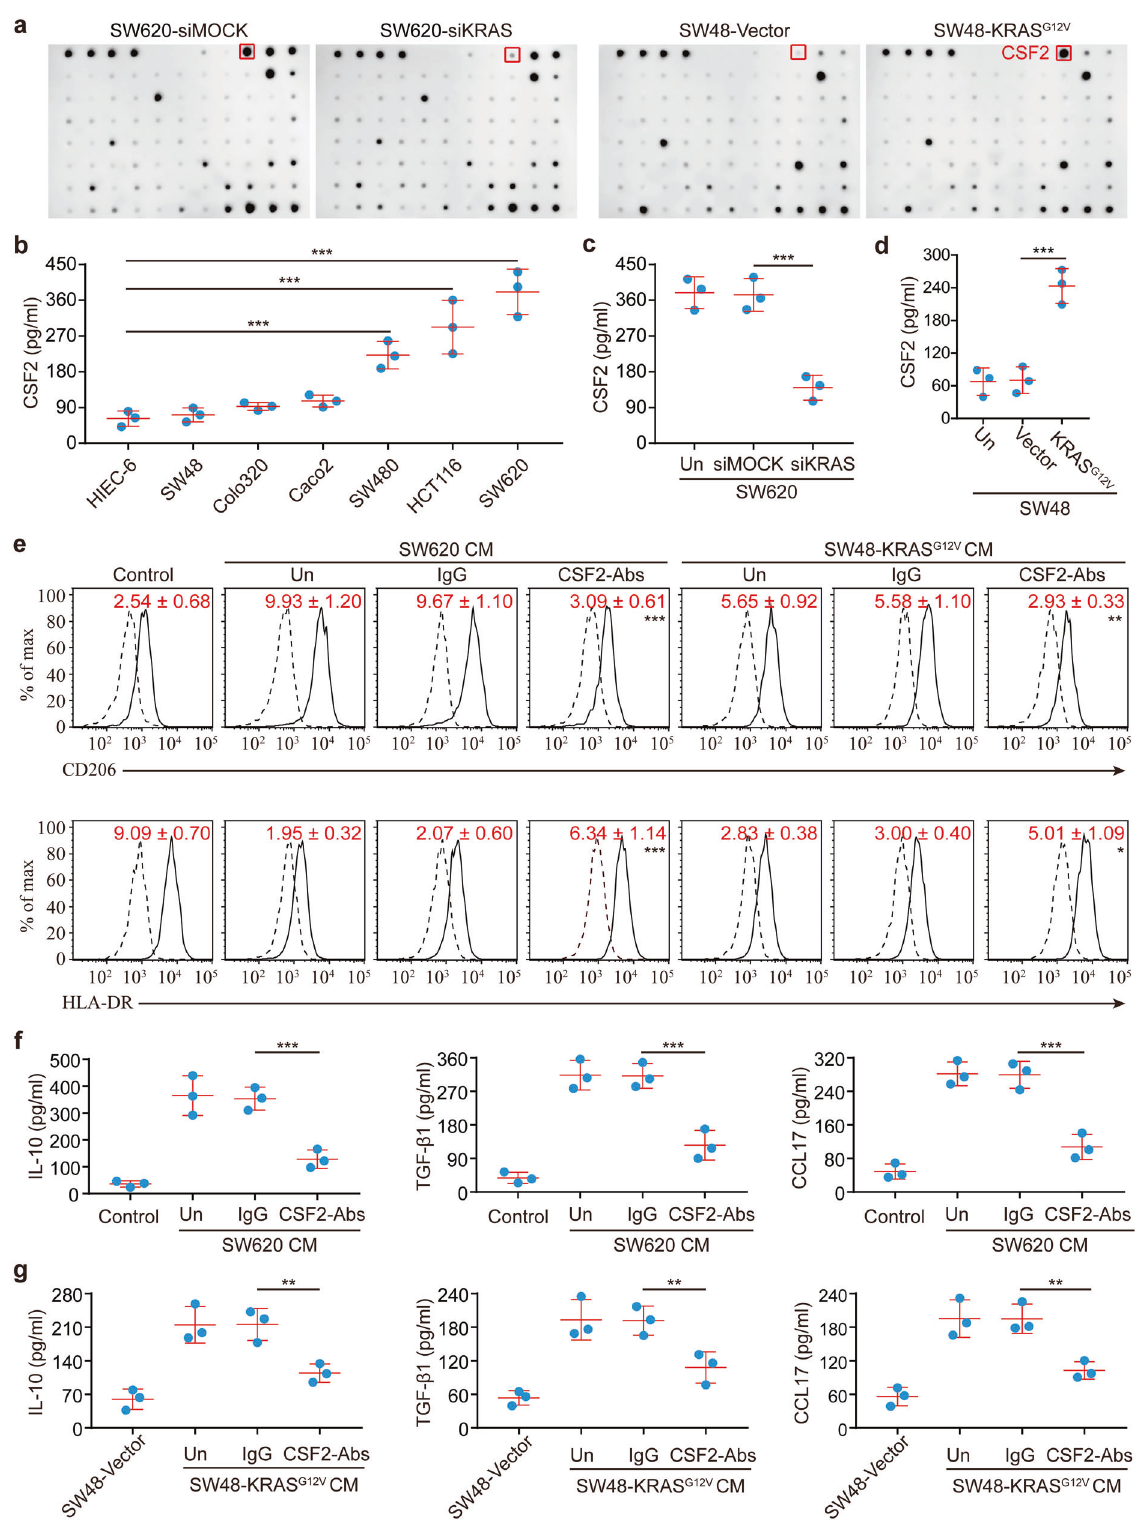
Fig. 4 CSF2 is required for the macrophage reprogramming by KRAS mutant CRC cells. a Cytokine array of the CM of the indicated cells. CSF2 is denoted on the array by the red box. b – d The levels of CSF2 in the CM of the indicated CRC cells as determined by ELISA assays ( n = 3). e Expression of CD206/HLA-DR in macrophages treated with 30% CM from the indicated tumor types as indicated in Fig. 2a – c in the presence or absence of control IgG or a CSF2 neutralizing antibody ( n = 3). The solid lines represent cells stained with monoclonal antibodies, and dotted lines represent those stained with isotype controls. Numerical values denote the relative mean fl uorescence intensity (RelMFI) normalized to isotype controls (mean ± SD). p -values are for comparison with “ IgG ” . f , g Cytokine levels in the media of macrophages treated as indicated in e ( n = 3). * p ≤ 0.05, ** p ≤ 0.01, and *** p ≤ 0.001, by one-way ANOVA ( b – g